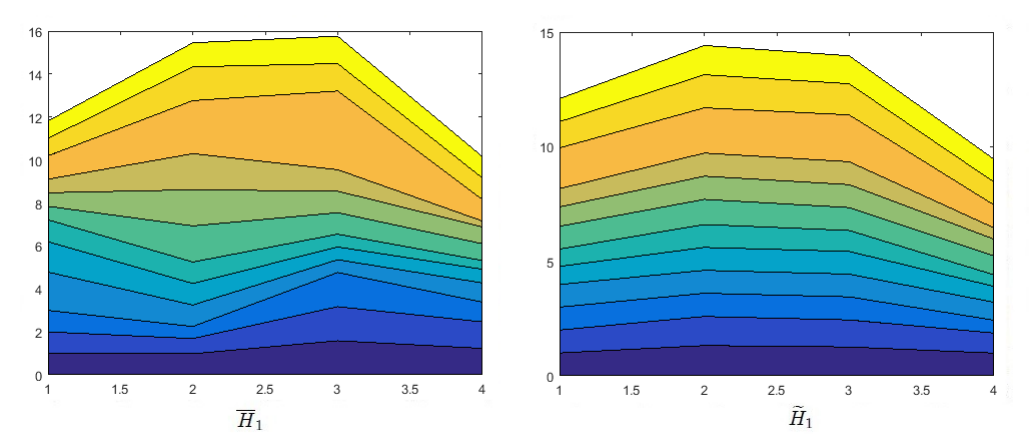
Figure 3. Area graphs of score values for H 1